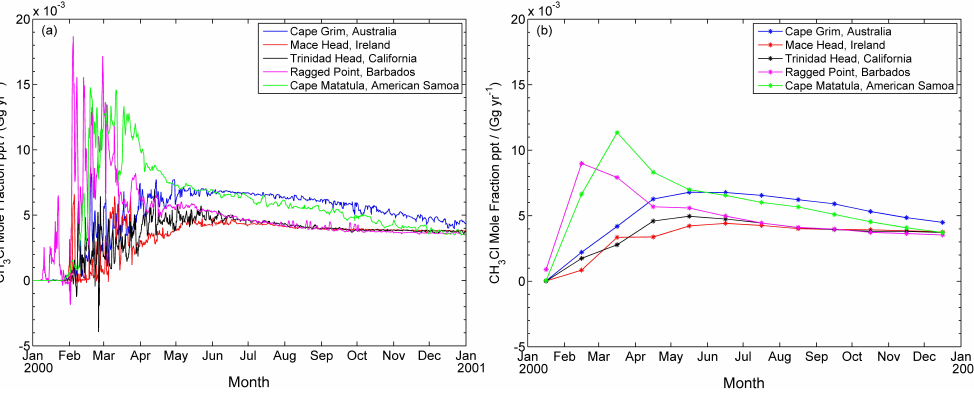
Fig. 2. MATCH-modeled sensitivities of CH 3 Cl (a) high frequency and (b) monthly mean mole fractions at each AGAGE site to a January 2000 emission pulse from African tropical plants. Eventually the mole fractions reach similar values for each site consistent with a CH 3 Cl emission pulse into a well-mixed atmosphere. In addition to dispersion, the sensitivities are affected by a slow CH 3 Cl decrease due to reaction with the OH